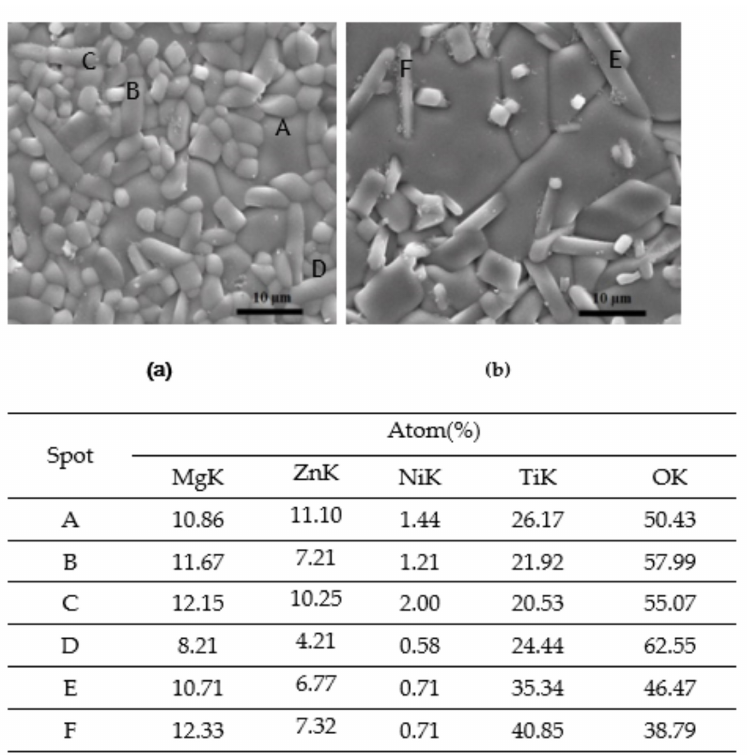
Figure 4. The EDS analysis of ( a ) (Mg 0.6 Zn 0.4 ) 0.95 Ni 0.05 TiO 3 sintered at 1200 ◦ C ( b ) (Mg 0.6 Zn 0.4 ) 0.95 Ni 0.05 Ti 2 O 5 sintered at 1250 ◦ C for 4